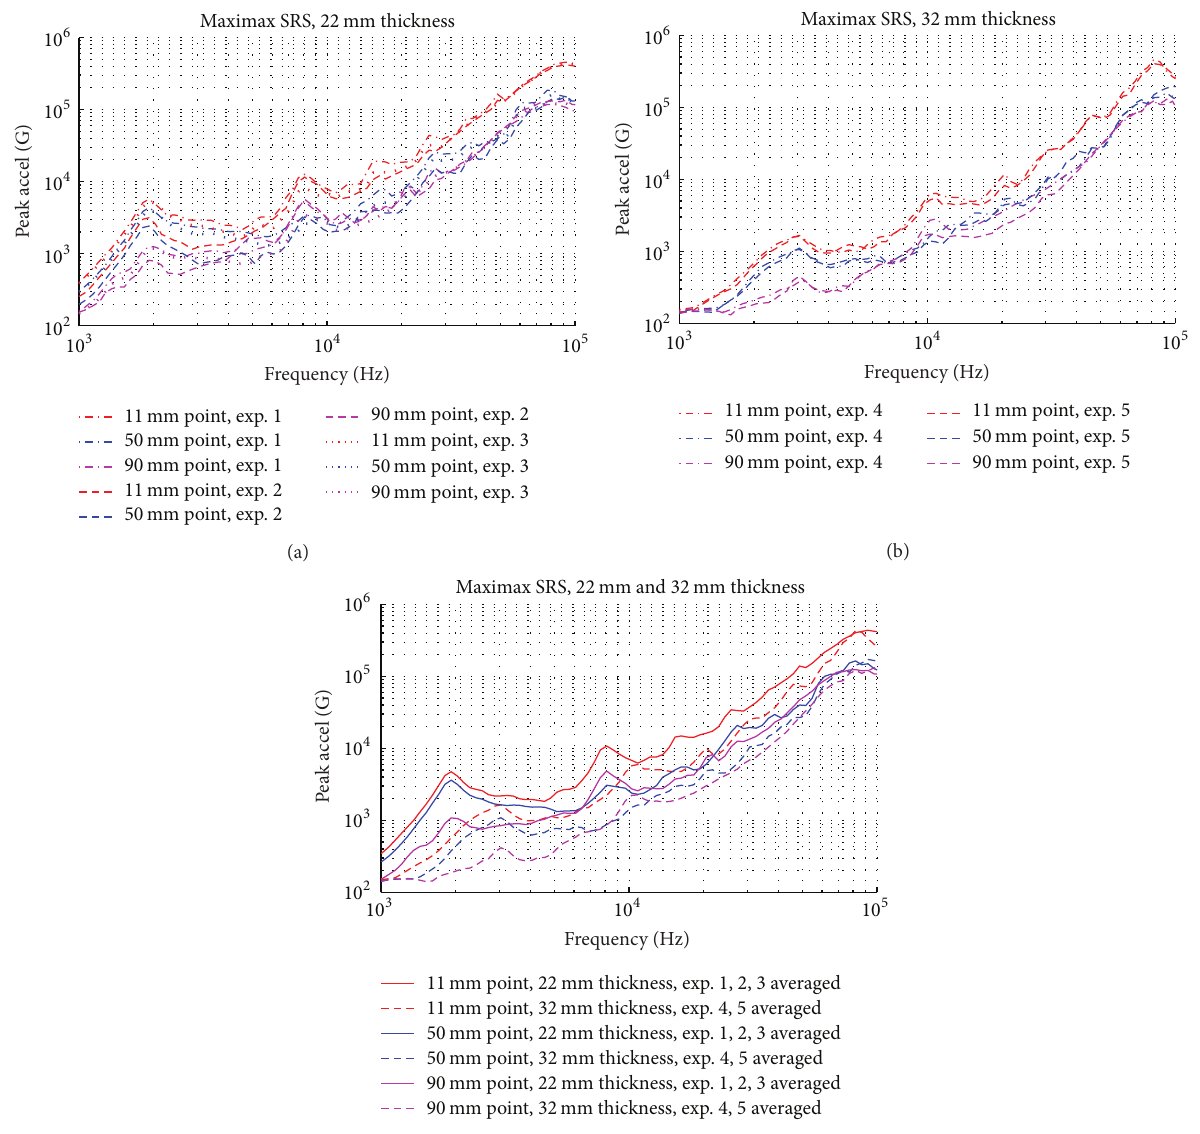
Figure 6: Measured pyroshock in terms of maximax SRS: (a) experiments 1 , 2, and 3 (the 22 mm thickness circular plate) and (b) experiments 4 and 5 (the 32 mm thickness circular plate). (c) Averaged results for the 22 mm thickness circular plate and the 32 mm thickness circular